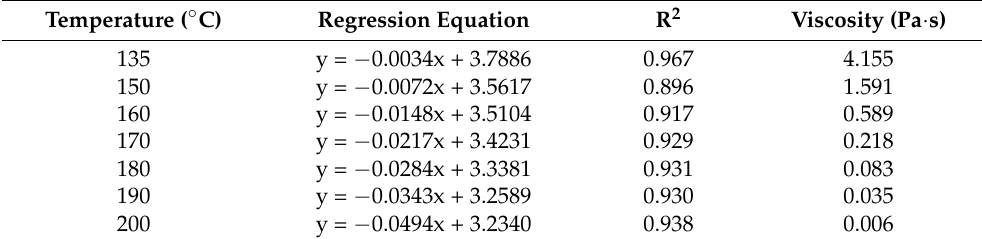
Table 5. Viscosity fitting results of CS-0.5.